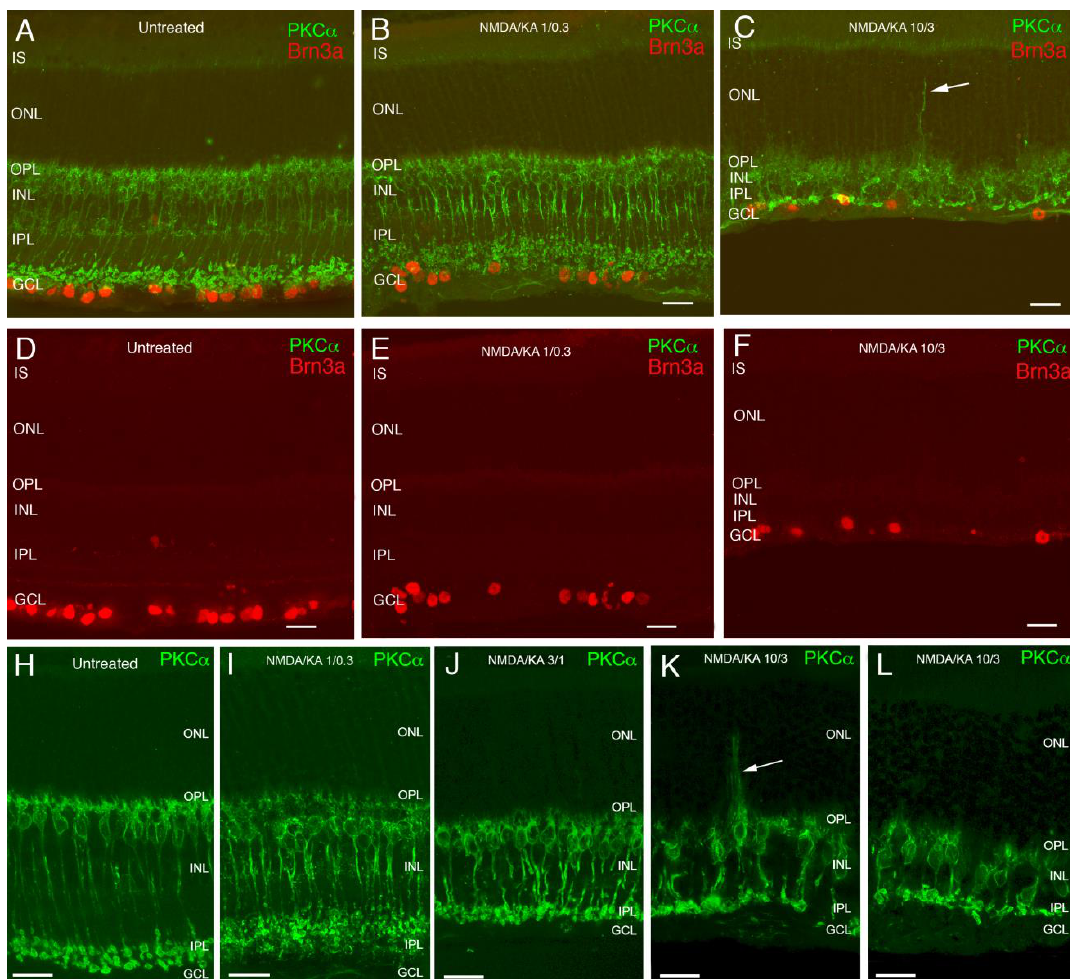
Figure 2. Effect of NMDA/KA treatment at different doses on ganglion cells and rod bipolar cells. Double immunolabeling with antibodies against PKC-alpha and Brn3a shows the morphology of the rod bipolar cells, with their axon terminal located in the ON stratum in the IPL (green) ( A – C , H – L ), and cell bodies of ganglion cells (red) ( D – F ). At a 1/0.3 concentration of NMDA/KA, ON rod bipolar cells are slightly shortened and a small decrease in the ganglion cell number is observed ( B , E , I ). At the 3/1 concentration of NMDA/KA, ON rod bipolar cells show an obvious shortening of their size, which accompanies the decrease in IPL thickness ( J ). At the highest NMDA/KA concentration of 10/3, a reduction in the number and size of rod bipolar cells is appreciated ( C , K , L ). Although a drastic length reduction of rod bipolar cells is obvious, these cells retain their dendrites and axons, adapting their morphology to the reduction in size of the IPL ( K , L ). Some of the bipolar cells present sprouting of their dendrites towards the ONL ( C , K , arrow). IS—inner segments; ONL—outer nuclear layer; OPL—outer plexiform layer; INL—inner nuclear layer; IPL—inner plexiform layer; GCL—ganglion cell layer. Scale bar of 20 µm.